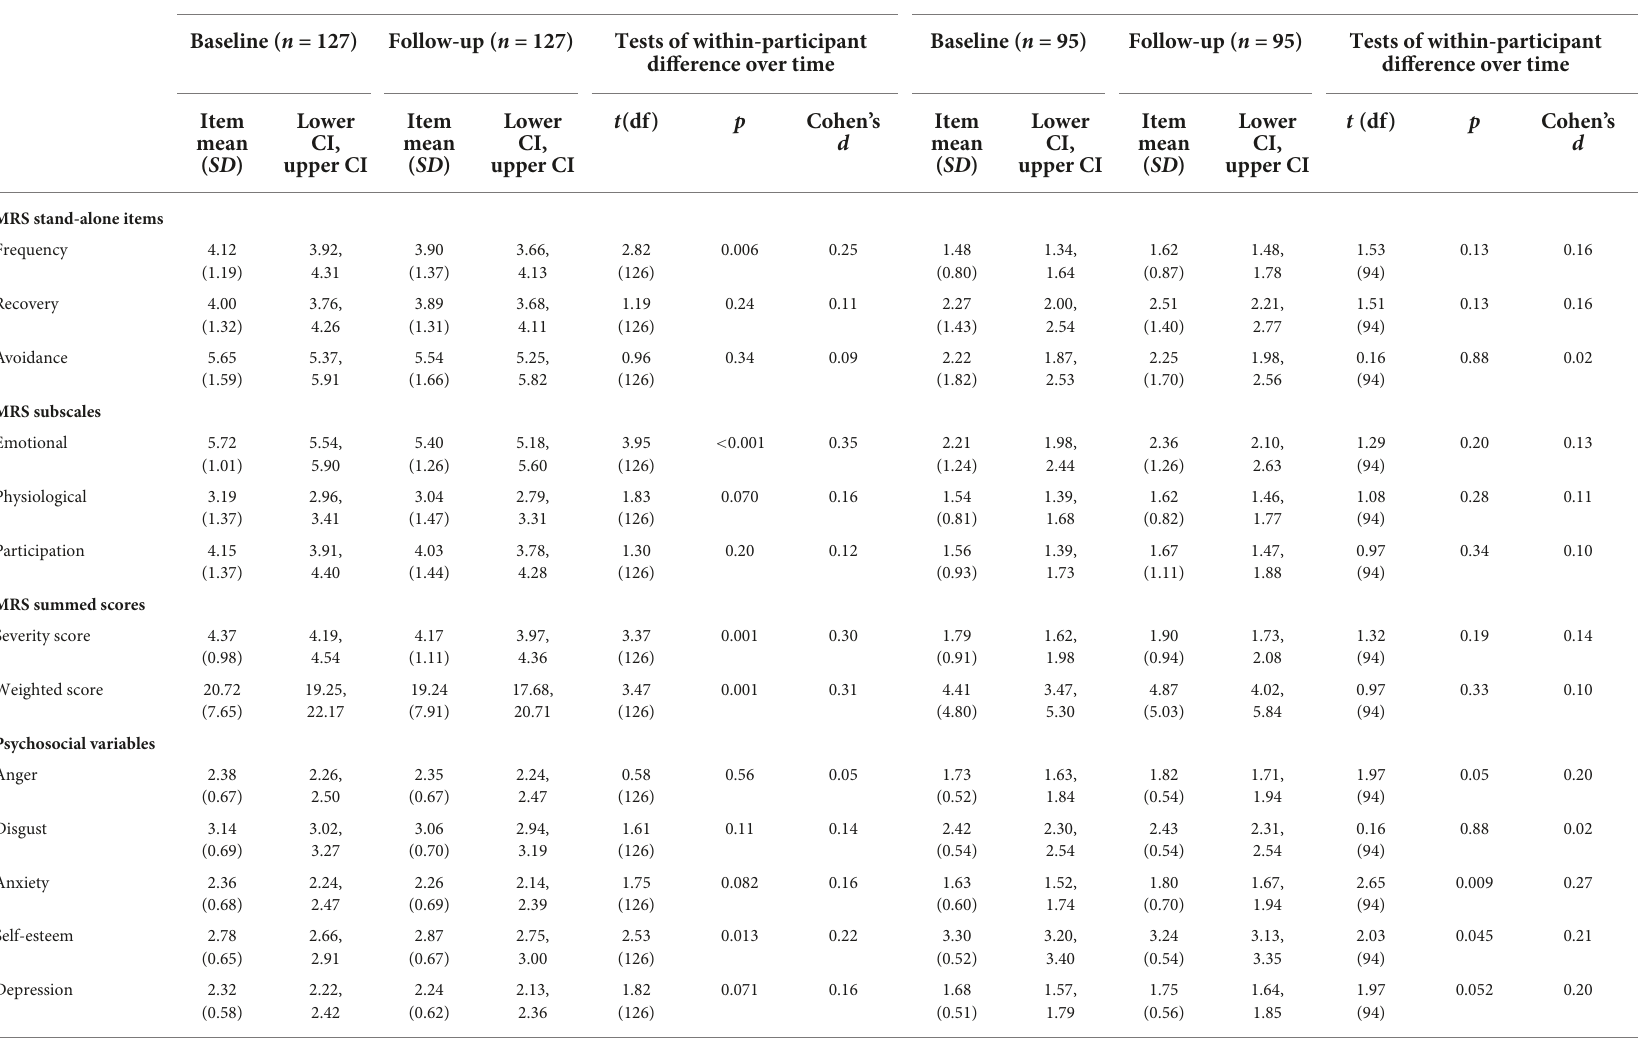
TABLE 7 Within-participant tests of difference over time for misophonic responses, psychosocial variables, and quality of life.